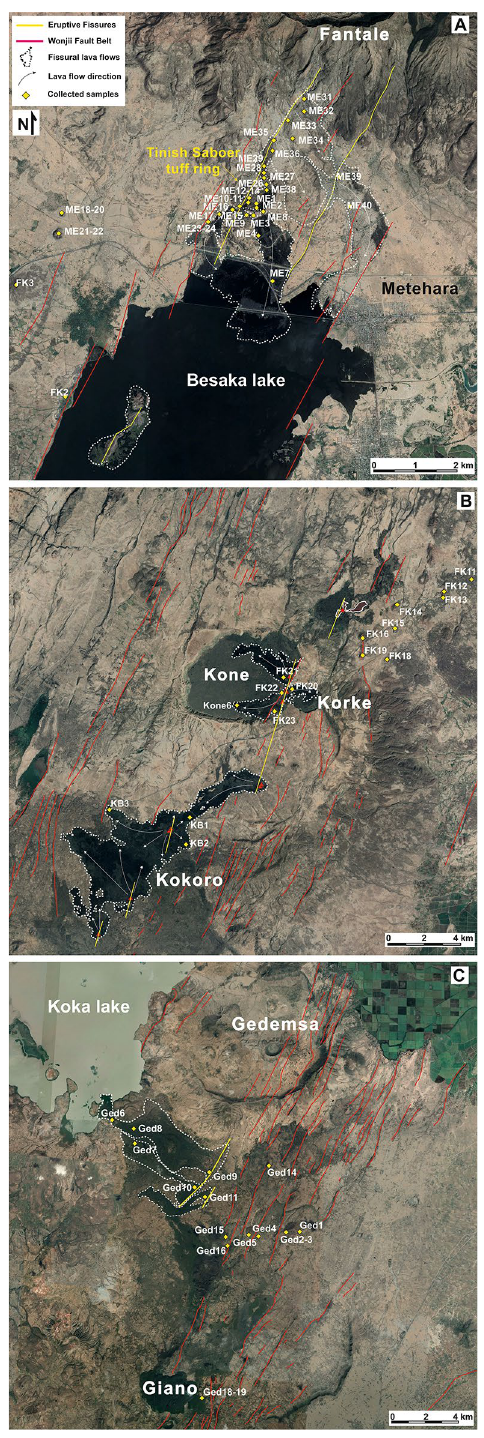
Figure 2. Detail of the areas of the main eruptive fissures found in the Northern Main Ethiopian Rift. (A) Satellite view (map taken from Google Earth, date of acquisition 1/11/2019; http:// earth. google. com) of the area of the southern flank of Fantale volcano, where two parallel Eruptive Fissures (EF) developed next to Metehara village (yellow lines) feeding two small lava flows toward south, into Lake Besaka; the westernmost fissure continued also into the Lake, feeding a small chain of scoria cones. In the western portion of the area, four Monogenetic Scoria Cones crop out (ME18-22 and FK2-3 samples). ( B) Satellite images (map taken from Google Earth, date of acquisition 1/11/2019; http:// earth. google. com) of the area of Kone volcano. Here, the 1810–20 CE eruption developed several eruptive fissures, from which modest lava flow fields formed within the Kone caldera and in the area of Kokoro. ( C) Satellite images (map taken from Google Earth, date of acquisition 12/23/2019; http:// earth. google. com) of the area south of Gedemsa volcano and of Koka